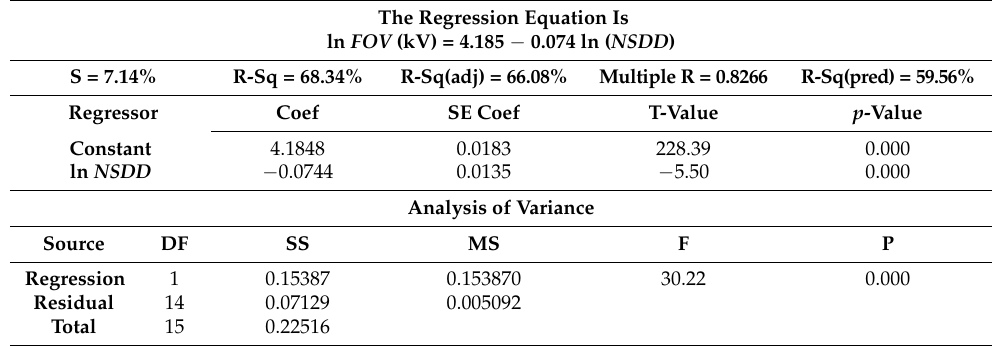
Table 3. Statistical results of NSDD based model for both partially soluble agricultural- and biological- polluted suspension